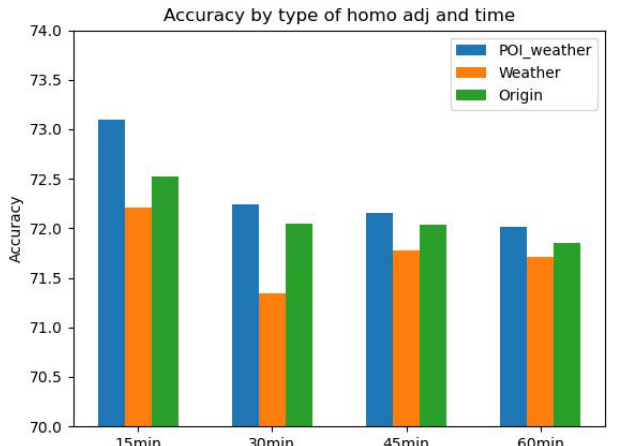
Figure 6. heterogeneous information embedding dimension and long-term predictive